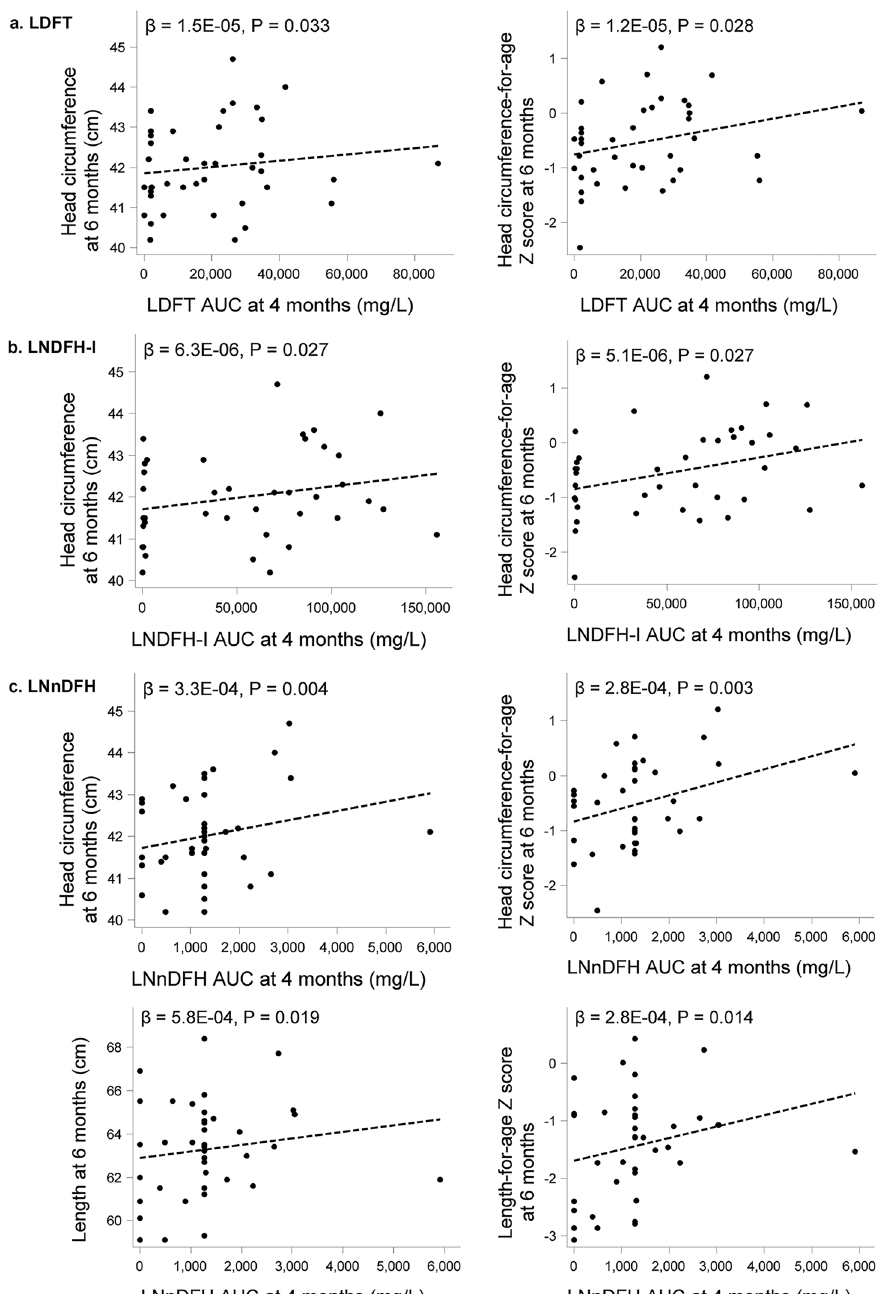
Figure 3. Scatterplots for select HMO Area Under the Curve (AUC) until 4 months of lactation and head circumference and length at 6 months of age ( a – c ) and length- and weight gain, respectively ( d , e ) from birth to 6 months of age (N = 41). LDFT, lacto-difucosyltetraose; LNDFH-I, lacto-N-difucosylhexaose-I; LNnDFH, lacto-N-neodifucohexaose; 2’FL, 2’fucosyllactose; 6’GL,